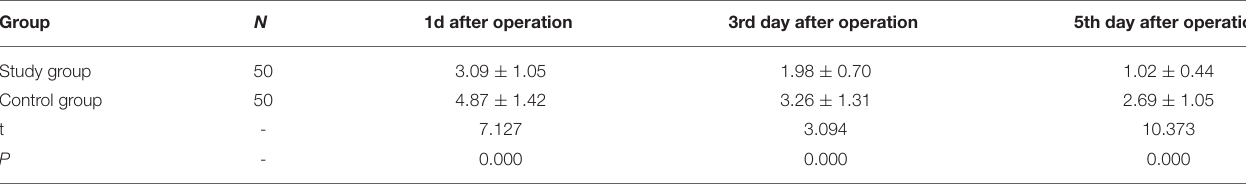
TABLE 5 | Comparison of VAS scores between the two groups ( ¯ X ± s, min). Group